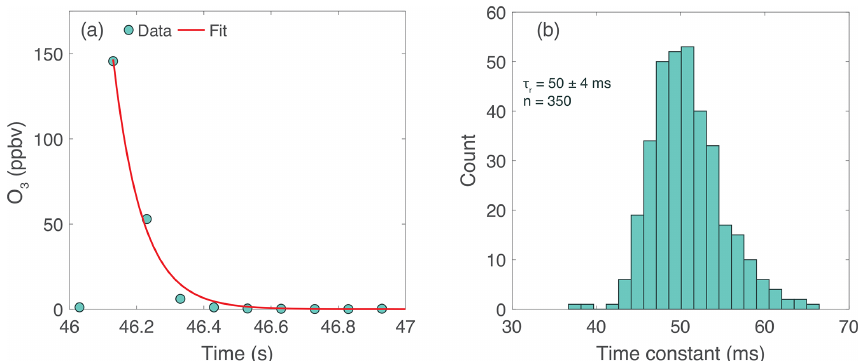
Figure 6. ROZE time response. (a) Ozone was injected into the flow system via a pulsed valve at 2s intervals with a sample flow of 18SLM. An exponential decay function was fitted to each individual pulse (pulse data shown in blue; fit shown in red). (b) Histogram of time constants for all 350 pulses. The e -folding decay time of 50 ± 4ms corresponds to a 3 e -fold cell flush rate of